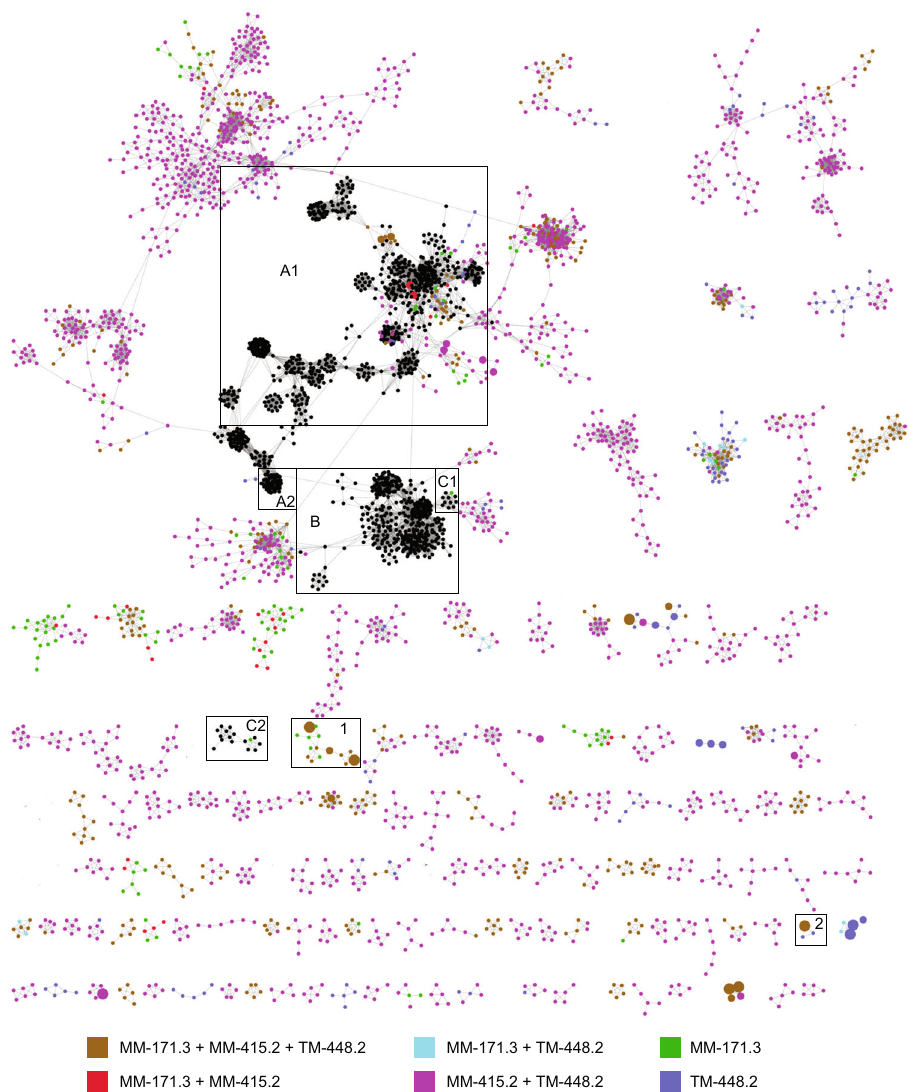
Fig. 1 Network displaying Äspö HRL contigs and viral isolates highlighting connections between groundwaters. A selected portion of the network analysis of the contigs from the three groundwaters along with sequences from bacterial and archaeal viral isolates in the NCBI RefSeq database (black nodes). Color coding of nodes represents the presence of the contigs in the groundwaters based on metagenome read recruitment. Boxes marked with letters refer to phages that mainly infect Gamma-, Beta-, and Alphaproteobacteria (A1 & A2); Firmicutes (B); and Bacteriodetes (C1 & C2). Boxes marked with numbers refer to clusters consisting of viral contigs both in the core and in individual groundwaters. Node sizes for Äspö HRL viral contigs are based on bp reads recruited divided by the contig size in kb and the metagenome size in Mb (smallest circle <50, medium circle 50 – 100, and largest circle >100 bp mapped/kb of contig/Mb of metagenome) for the metagenome from which the contig originated (see Supplementary Fig. 3 for information regarding the groundwater type where a speci fi c contig originated). Reference viral isolates in the NCBI RefSeq database are all presented using the smallest circle size and do not represent abundance. The complete and unedited Cytoscape fi gure is available in Figshare 35